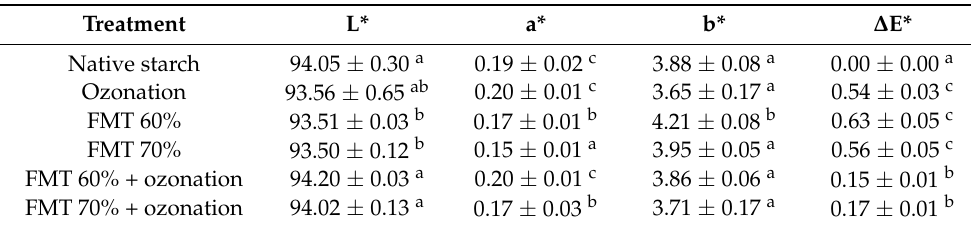
Table 1. The color of native adlay starch and adlay starch modified by FMT and ozonation.